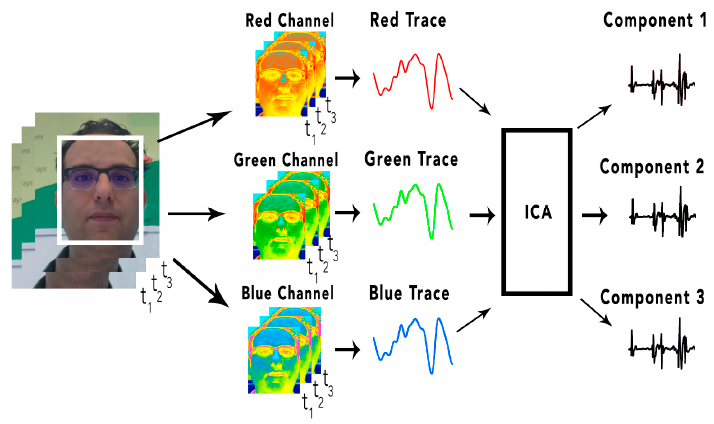
Figure 5. Obtaining the plethysmographic signal.